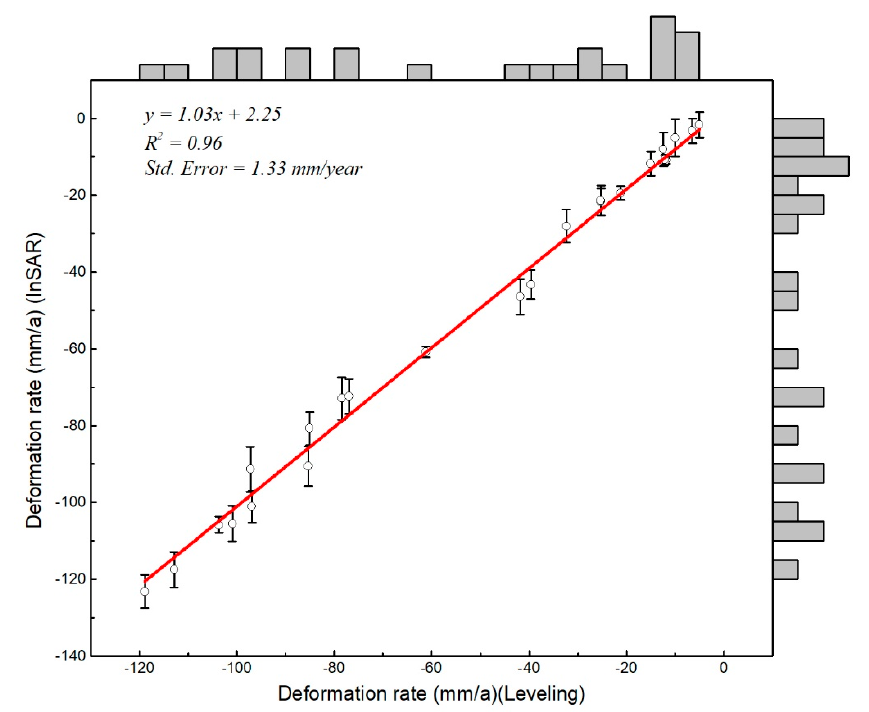
Figure 6. Comparison of interferometric synthetic aperture radar (InSAR) and ground-leveling-derived deformation rates at the 24 benchmarks during 2010–2017. The correlation coefficient is 0.96 with a standard deviation of 1.33 mm/year.